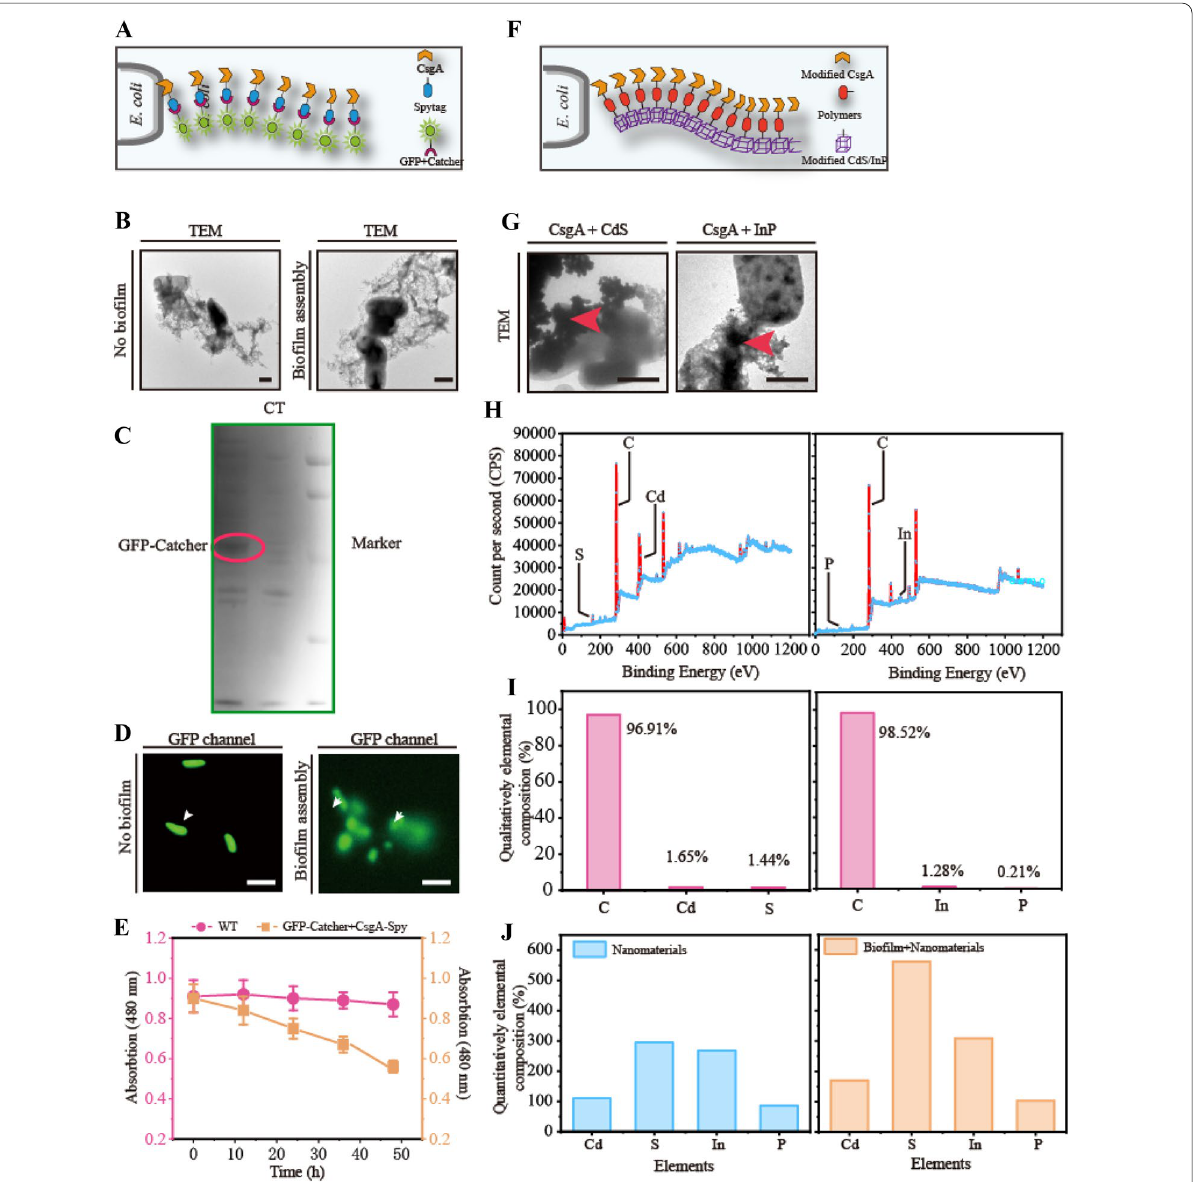
Fig. 2 Self-assembly of covalent immobilization proteins and nanoparticles based on biofilms. A The schematic diagram of self-assembly of Spy-Tag with GFP-catcher in E. coli MG1655. B The TEM exhibition in different E. coli MG1655. C The SDS-page exhibition in different E. coli MG1655. D Comparing the changes of assembly and no-assembly biofilm, expression and no-expression system by fluorescence detection. E The changes of absorption with or without biofilm. F The schematic diagram of self-assembly of nanoparticles with E. coli . G Comparing the TEM with InP or CdS in E. coli MG1655 biofilm. H , I The confirmation and atom account of randomly chosen biohybrids through XPS analysis. J Detecting concentration of Cd, S, In, and P in different E. coli through ICP-MS. For C, n 3. Error bars, mean s.d. Scale bar for B , G is 1 μm, scale bar for ( D ) is 5 = ±